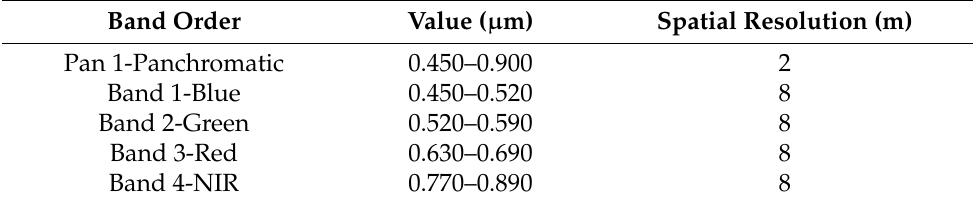
Table A1. Parameters of GF-1 PMS multi-spectral satellite